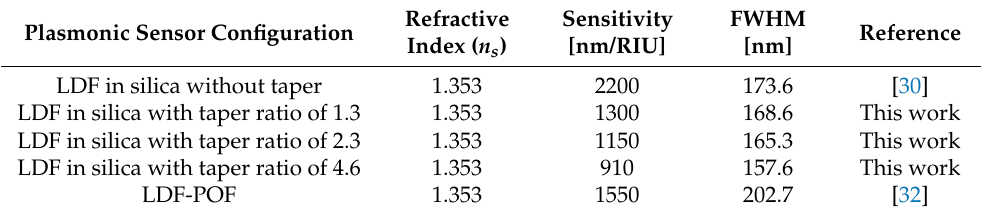
Table 1. Comparison between different LDFs configurations, at a fixed refractive index equal to 1.353. Plasmonic Sensor Configuration